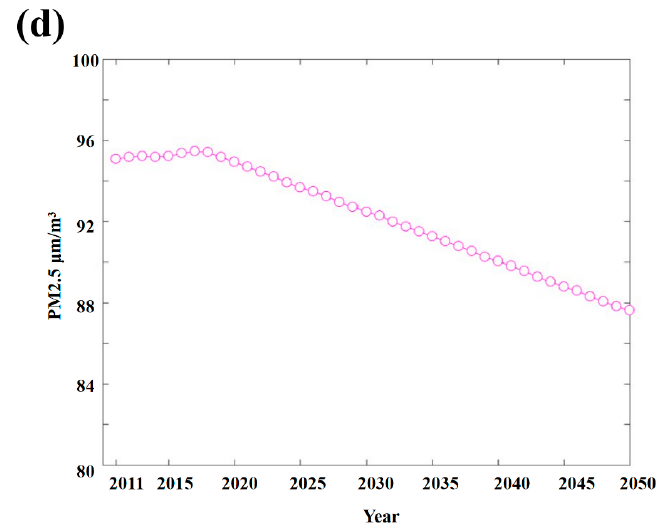
Figure 12. Impact of the vehicle emission reduction ( a ), petrochemical production emission reduction ( b ), coal combustion emission reduction ( c ) and greening and reducing dust ( d ) on PM2.5 in Beijing.